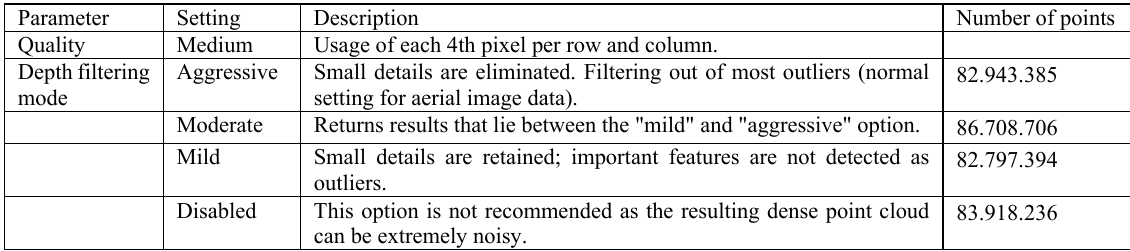
Figure 2. Phase One IXU 1000 (100Mpix) (top), Coptersystems Multicopter (bottom)